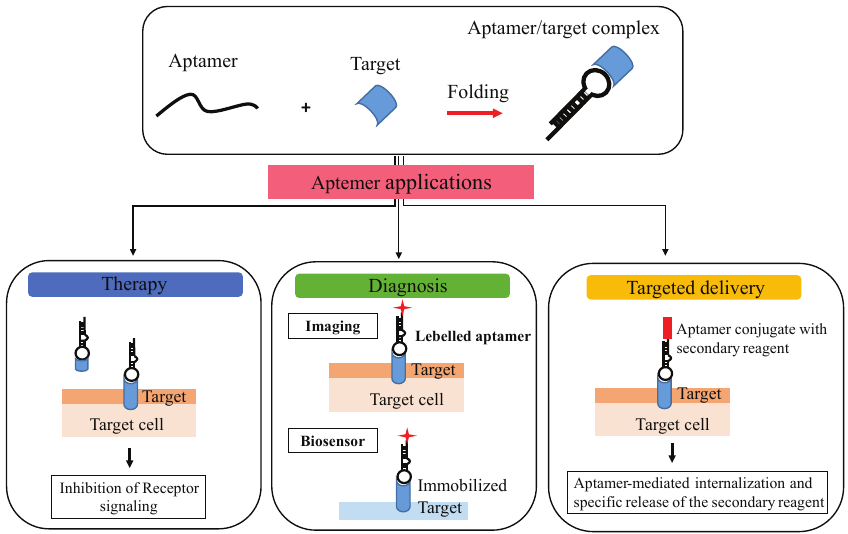
Figure 3. Aptamer applications. Aptamers bind with high affinity and specificity to their target molecules by folding in tridimensional structures and show great potential as therapeutic, diagnostic, and delivery